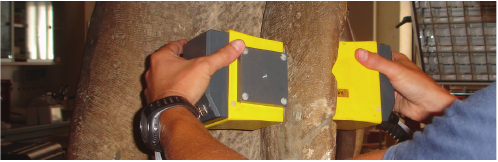
Figure 3: Transmitting and receiving GPR antennas (IDS, 1600 MHz) on the statue of S. Michele Arcangelo (Gagini’s appre- ntices,1530-50), at the Museum Abatellis, Palermo Italy